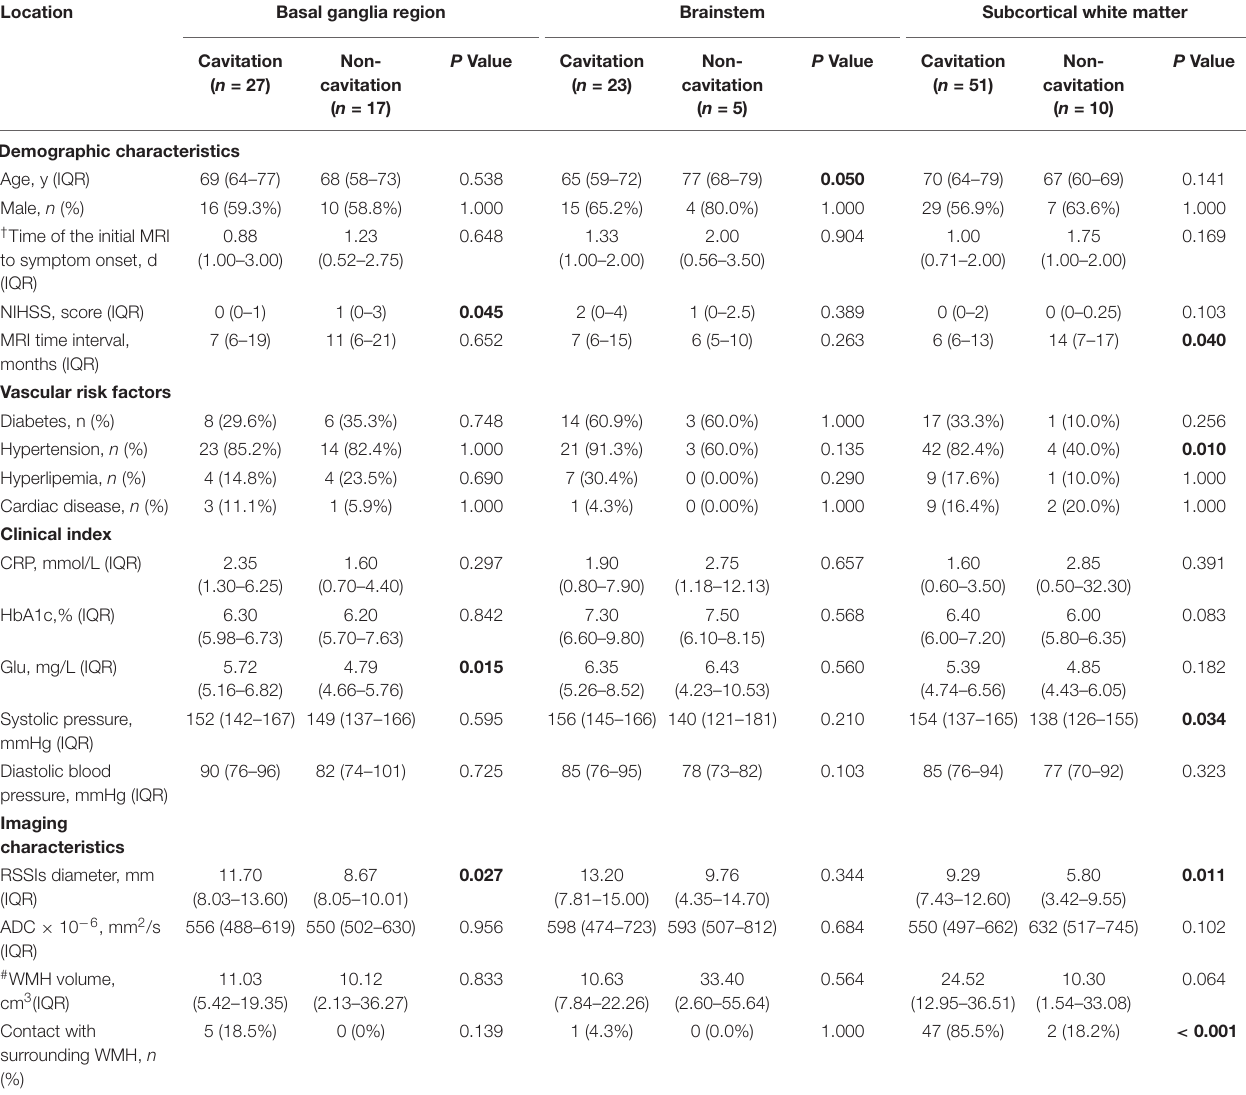
TABLE 2 | Comparisons of RSSIs in different locations with and without cavity formation on follow-up MRI. Location Basal ganglia